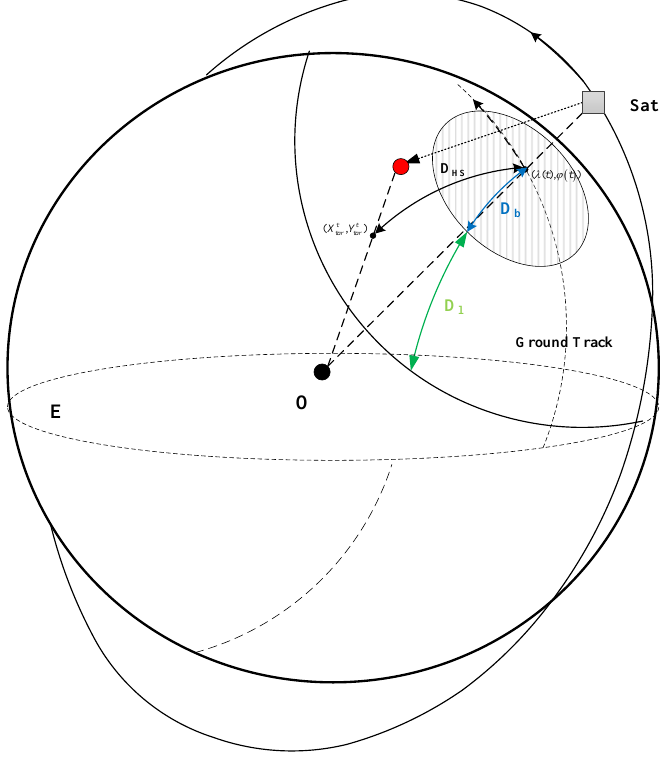
Figure 3. Dynamic observation area analysis.